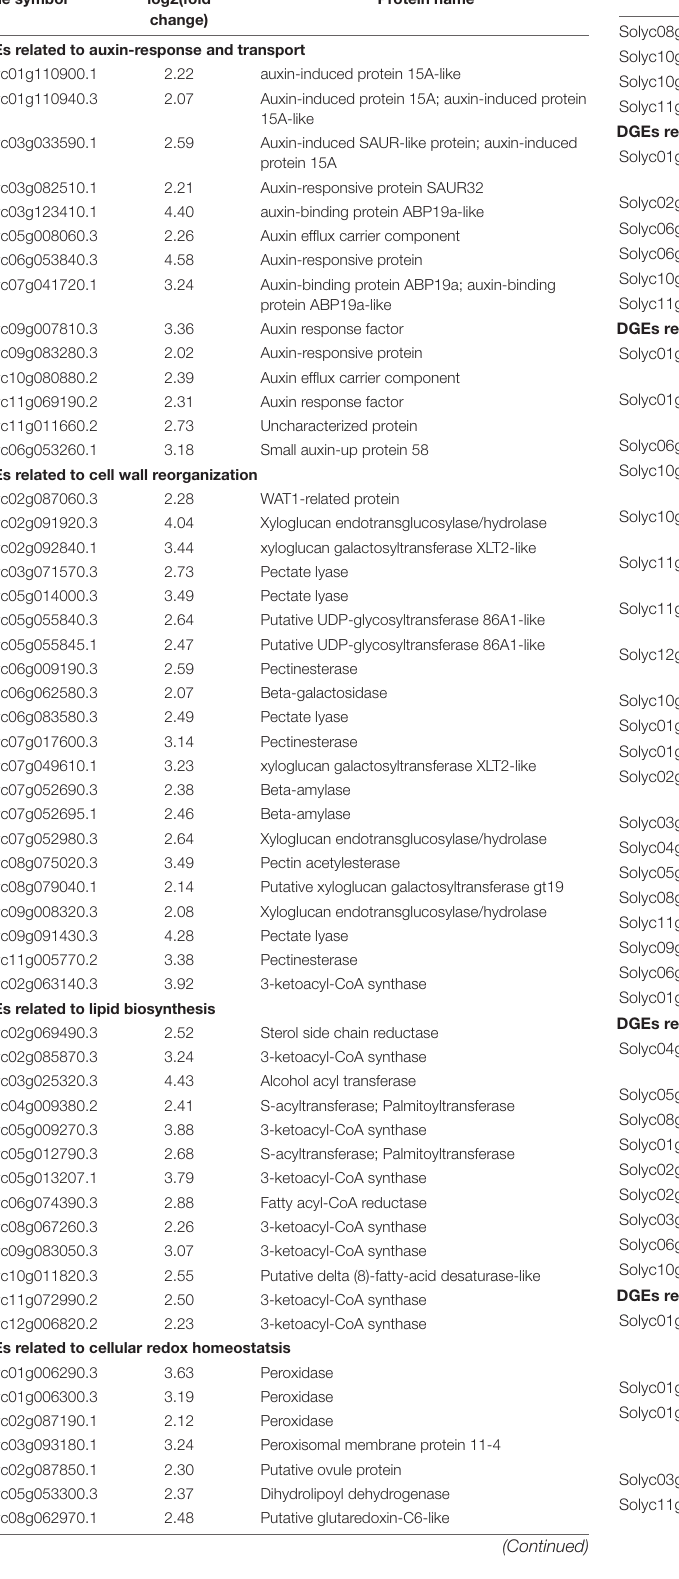
TABLE 1 | Upregulated DEGs in overexpressed OE lines compared with the wild-type (WT) eggplant line. Gene symbol log2(fold Protein change)